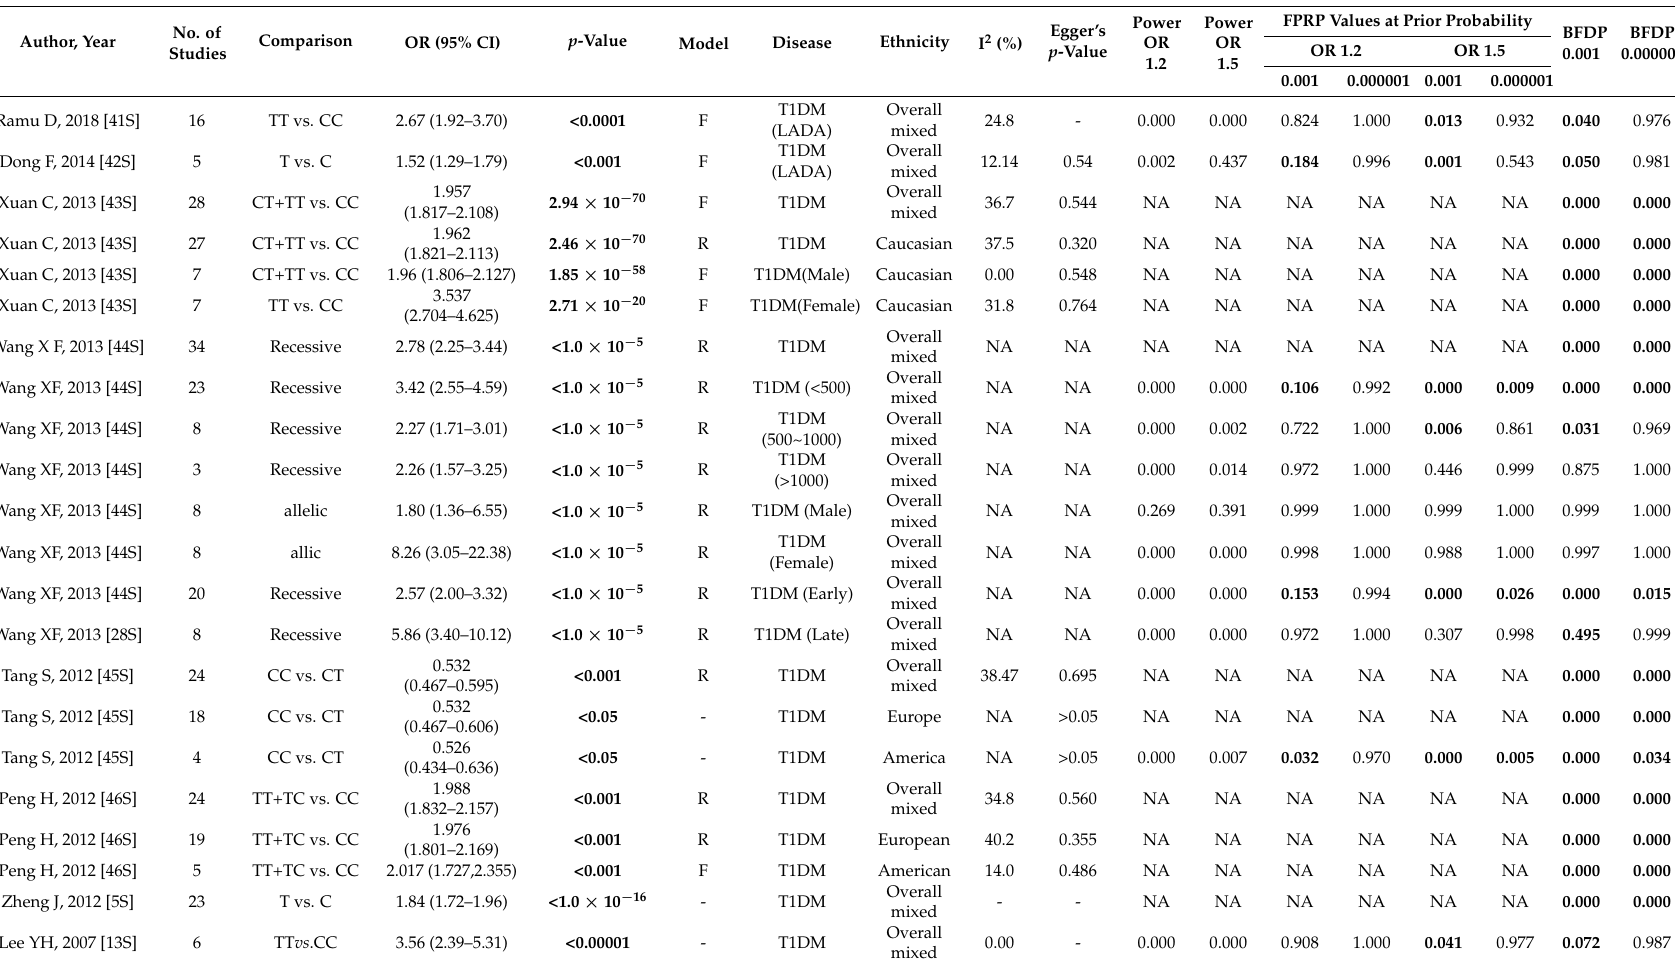
Table 7. Meta-analysis results of associations between type 1 diabetes mellitus (T1DM) and the PTPN22 1858 C/T polymorphism from observational